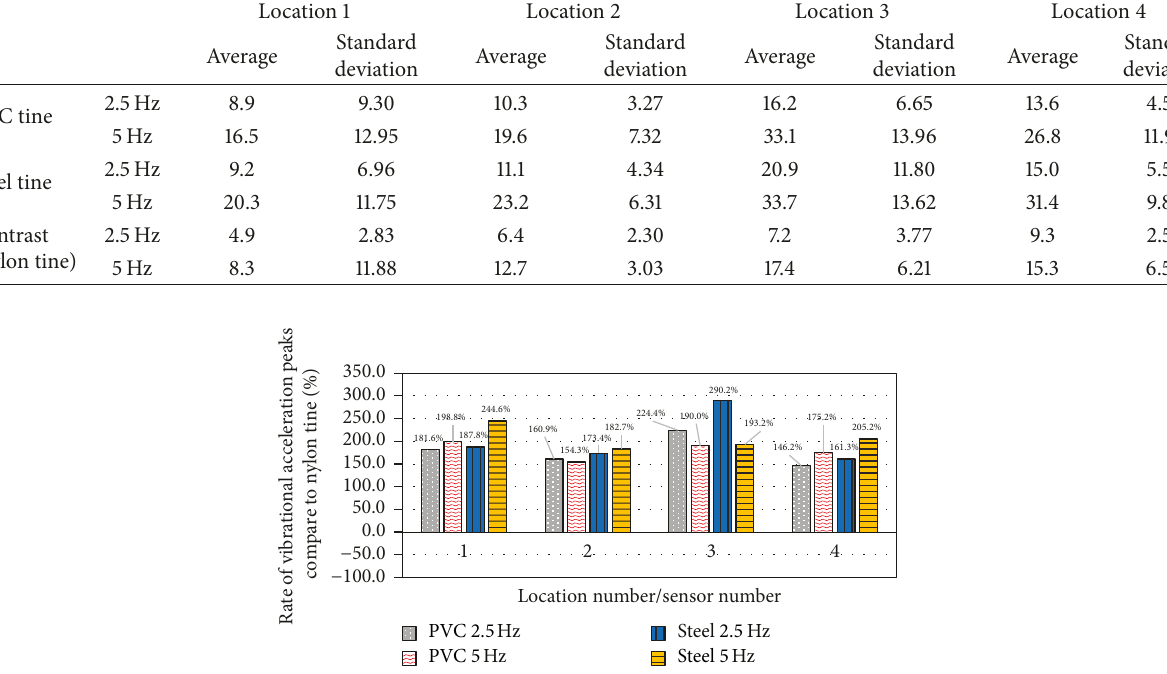
Figure 11: The rate of vibrational acceleration peaks exerted by straight PVC tine and straight steel tine compared to straight nylon tine for trial 1.